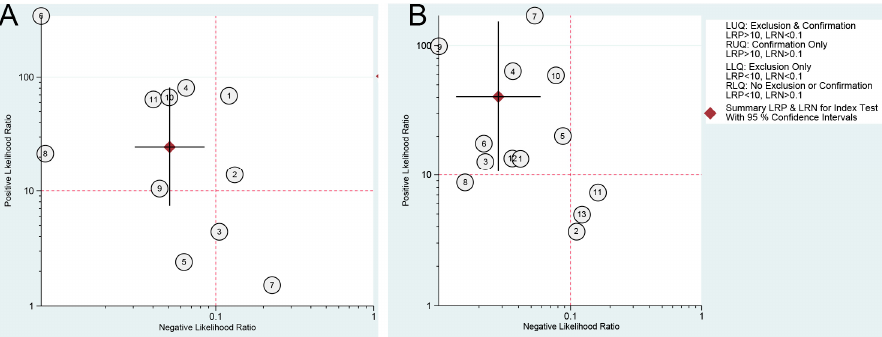
Figure 7. Likelihood ratio scattergrams of ( A ) ICA- and ( B ) NAIA-based POCTs for PEDV testing.